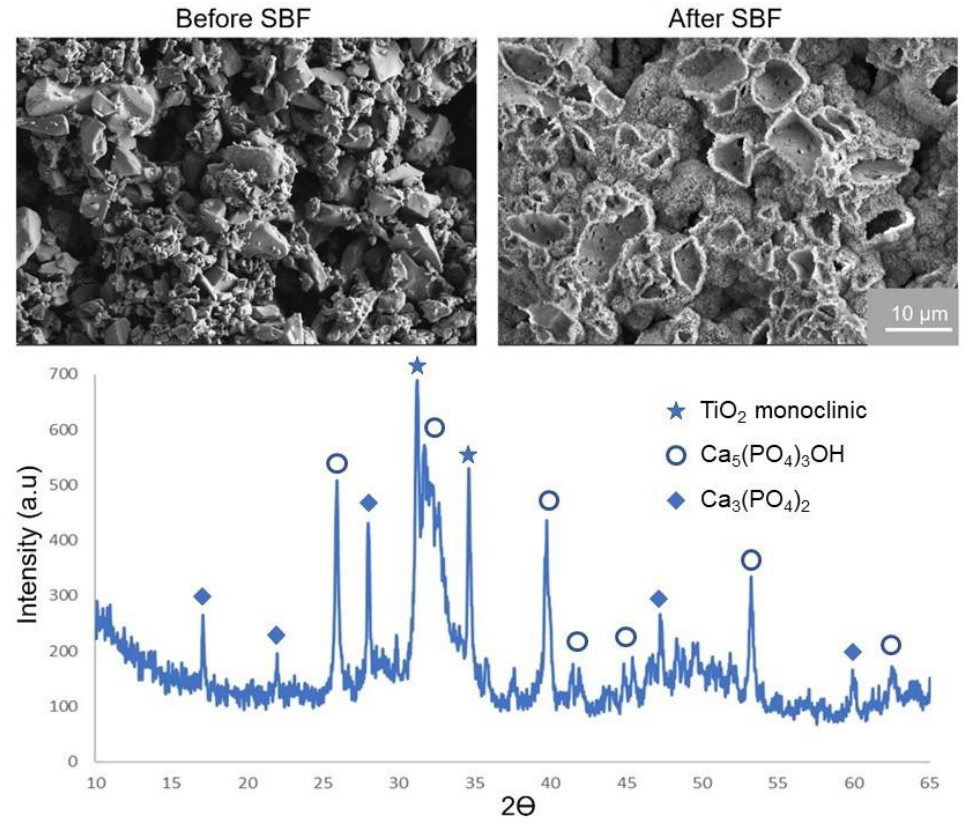
Figure 10. SEM top view images before and after immersion in SBF for the porous c.p. Ti substrate with a pores range size of 355 – 500 µm and XRD pattern after SBF (21 days in SBF).